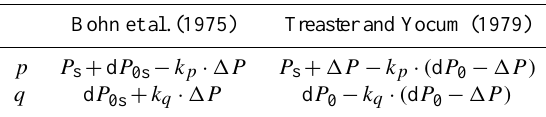
Table A1. Calculation of static and dynamic pressure from five-hole probe measurements with two different